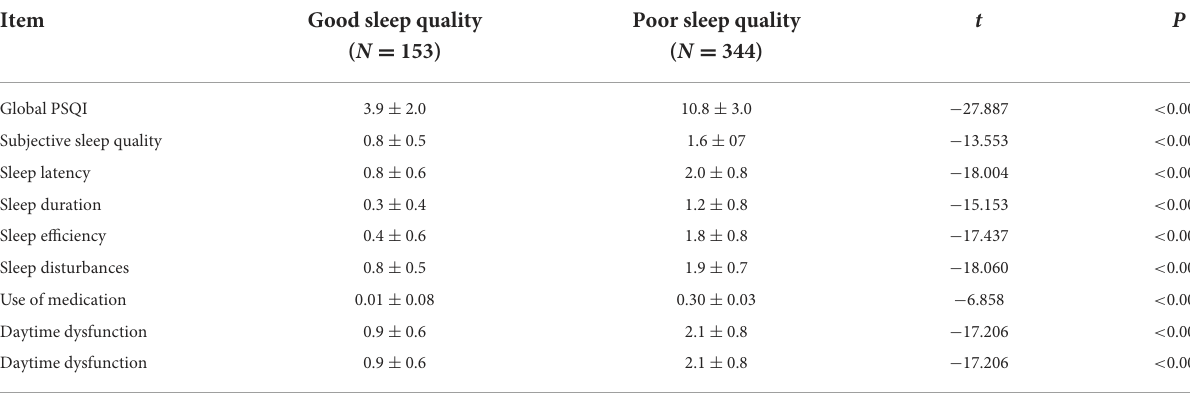
TABLE 1 Sleep quality in patients with tuberculosis.